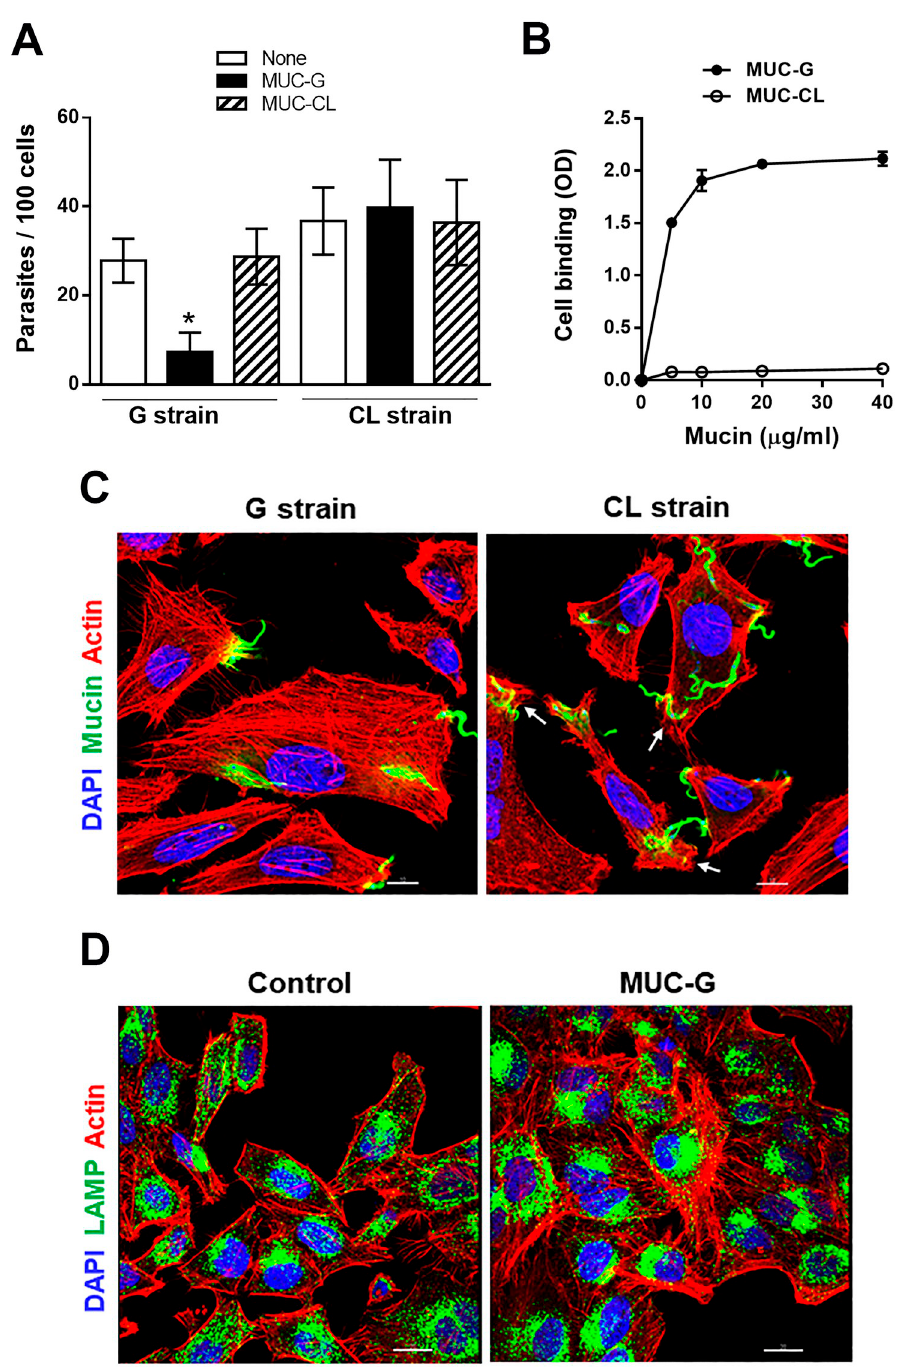
Fig 2. Inhibition of T . cruzi G strain MT internalization and host cell lysosome spreading by purified G-MUC. ( A ) HeLa cells were incubated for 1 h with MT of G or CL strain, in absence or in the presence of mucins purified from G strain (G-MUC) or CL strain (CL-MUC), and the number of intracellular parasites was quantified. Values are the means ± four independent assays. Note the significant decrease in G strain MT invasion in the presence of G-MUC ( � P < 0.001). ( B ) HeLa cells, grown in ELISA microtiter plates, were fixed and incubated for 1 h with MUC-G or MUC-CL at the indicated concentrations. Binding of mucin was revealed by mAb 2B10. The assay was performed in triplicates. ( C ) HeLa cells were incubated for 30 min with G strain or CL strain MT and processed for immunofluorescence analysis for detection of actin (red), nucleus (blue) and mucin (green). Confocal microscopy visualization, under 63x objective, showed thick F-actin filaments in cells incubated with G strain and